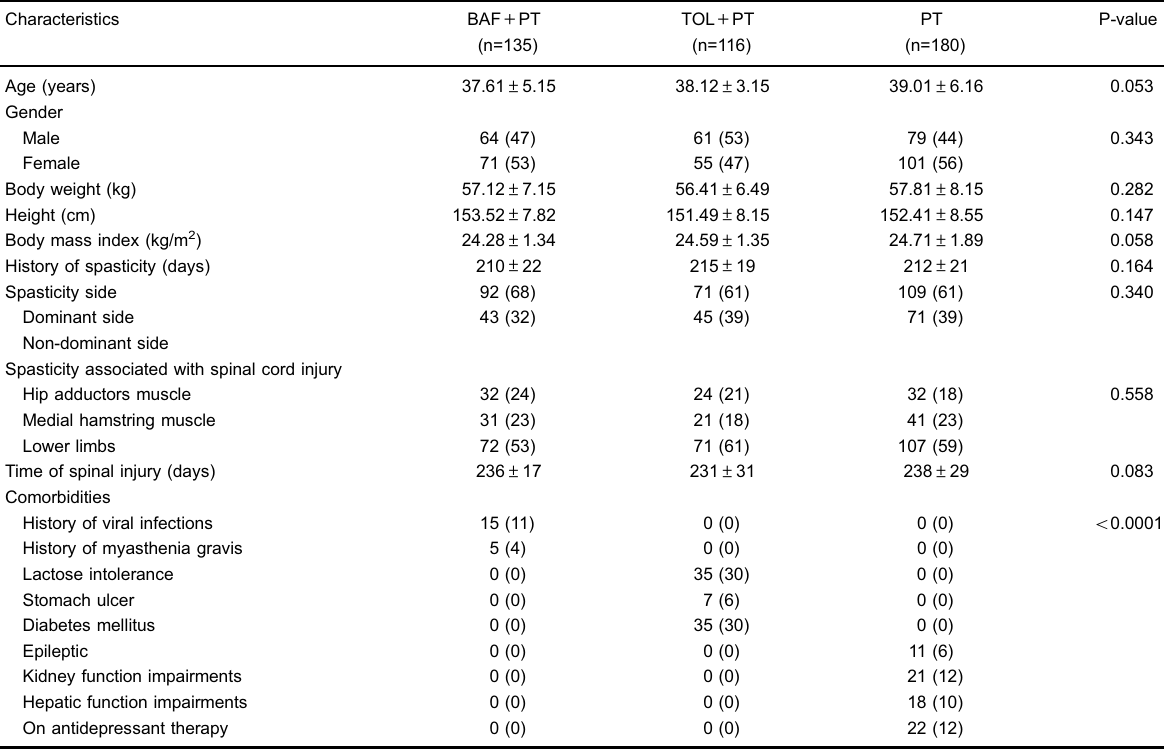
Table 2. Demographic and spasticity characteristics before interventions.